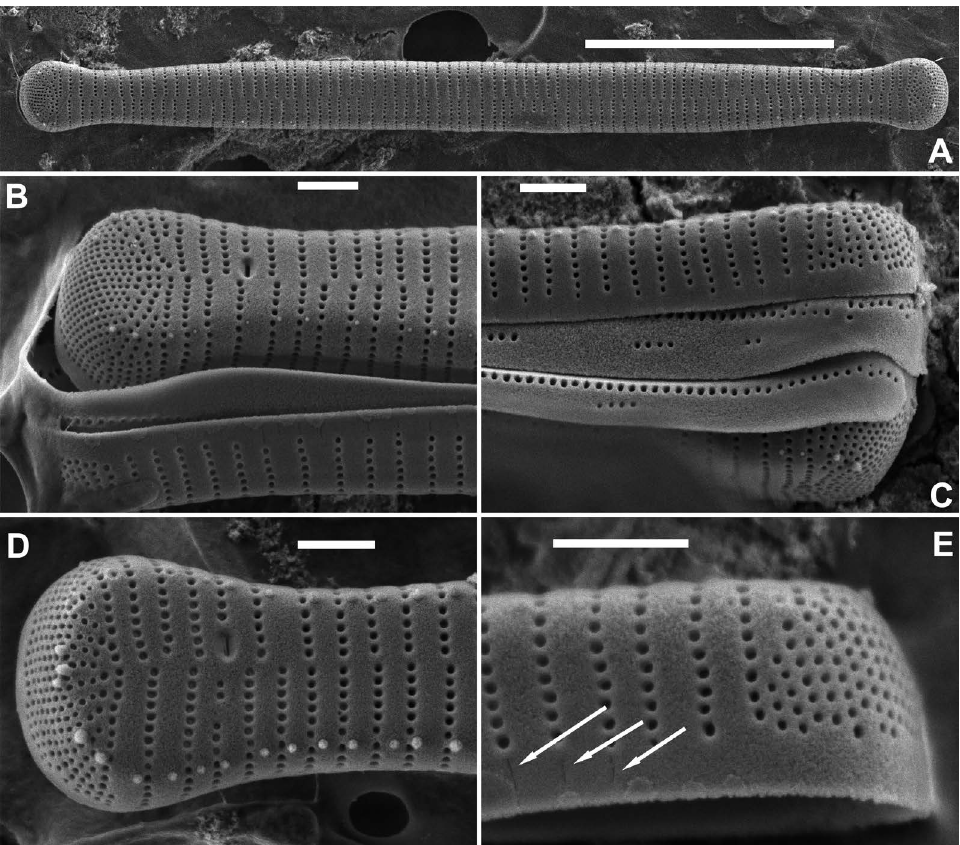
Figure 2 – Distrionella coxiana , SEM of the type population from Rancho Hambre, Tierra del Fuego (sample RH2016-CP4-PER2): A, external view of an entire valve; B, external detail of the valve apex showing the apical porefield and the rimoportula; note the presence of the small spines and the perforations of the girdle bands; C, external detail of the girdle bands showing the row of poroids on the copulae, the second row is not continuous but consists of short lines of poroids; D, external detail of the valve apex showing the apical porefield and the position of the rimoportula; E, external detail of the valve mantle with small plaques adjacent to the margin and the hyaline border. The arrows indicate small slitlike areolae on the mantle edge. Scale bars: A = 10 µm; B–E = 1 µm.